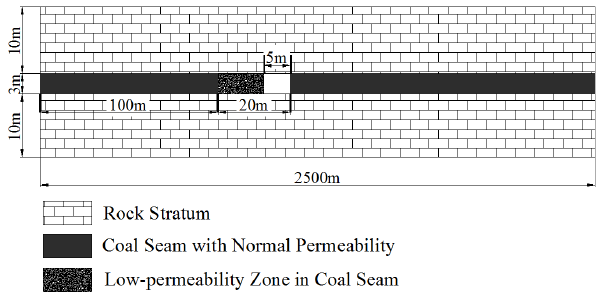
Figure 7. Geometry and boundary conditions. 3